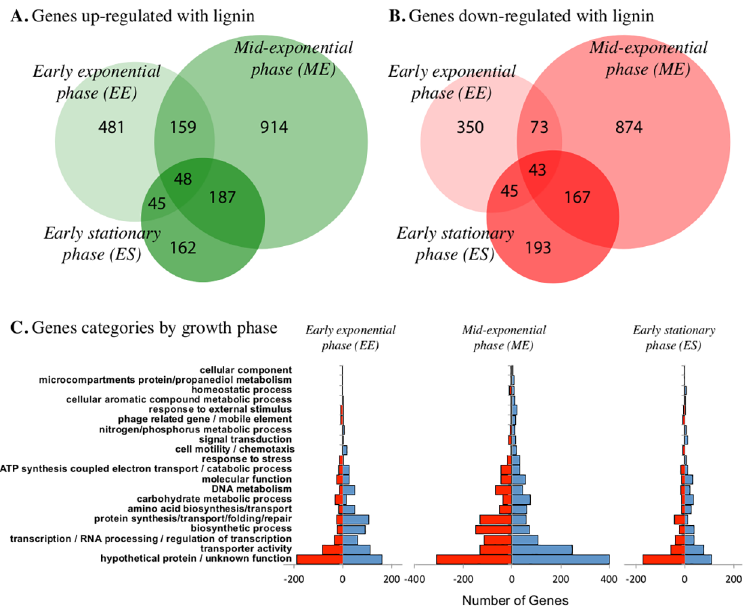
Fig 2. Venn diagrams of differentiallyexpressedgenes, where (A) green circles indicate numberof total genesare up-regulated each time point, and (B) red circles indicate numberof total geneswere down- regulatedeach time point. EE indicates cells analyzedin early exponential phase, ME, mid-exponential phase and ES, early stationary phase, where actual times of samplingeach cell populationis indicatedin the methods as well as in Fig 1A. (C) Changesin the gene profile as a result of ligninexposurein early exponential phase, mid-exponential and early stationary phase of growth. In the right side of each chart (blue), numberof genes with increasedrelative abundance, and in the left side (red), numberof genes with lower relativeabundance.The genes are groupedaccordingto functionalclass as definedby COG annotation.